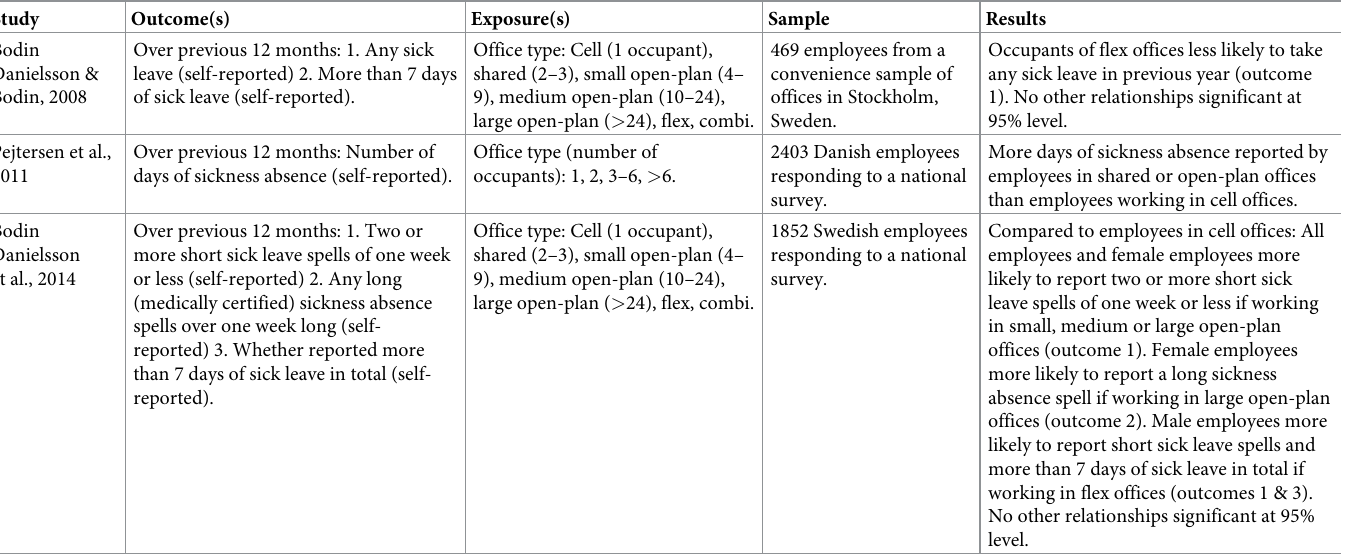
Table 1. Summary of previous research examining associations between office type and sickness absence. Over previous 12 months: 1. Any sick leave (self-reported) 2. More than 7 days of sick leave